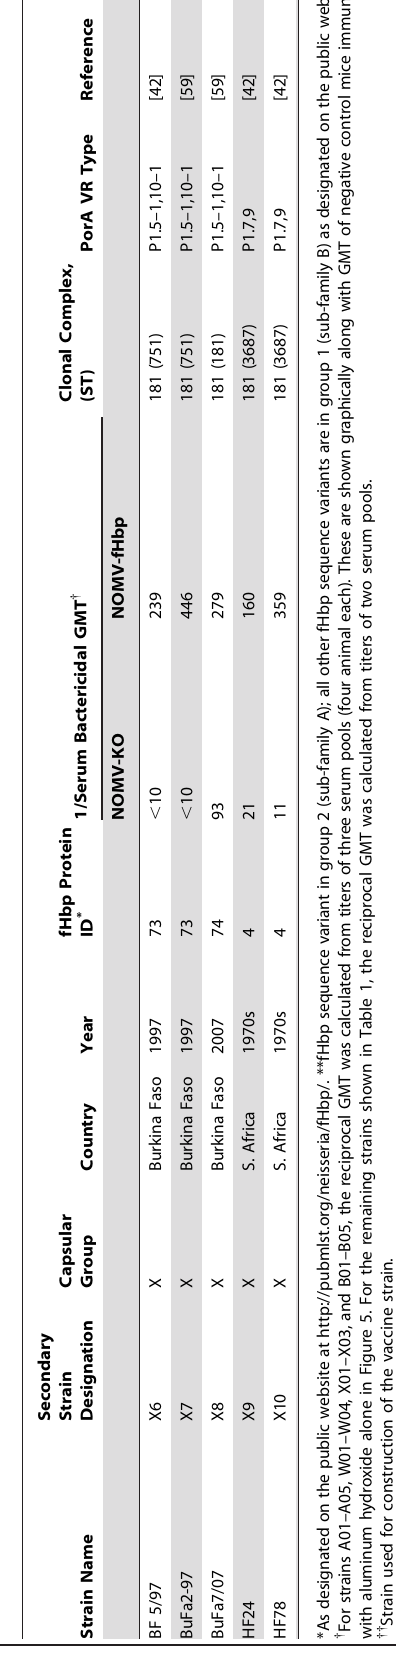
Figure 3. Detection of fHbp in NOMV vaccines by Western blot using anti-fHbp mAb JAR 5. rfHbp, recombinant fHbp ID 9. OE, NOMV-fHbp vaccine with over-expressed R41S mutant fHbp prepared from the mutant vaccine strain with D lpxl1 and D capsule; KO, NOMV prepared from a triple knockout ( D fHbp , D lpxl1 , and D capsule); WT, NOMV vaccine prepared from the wildtype strain. A total of 0.25 m g of NOMV was loaded in each lane.